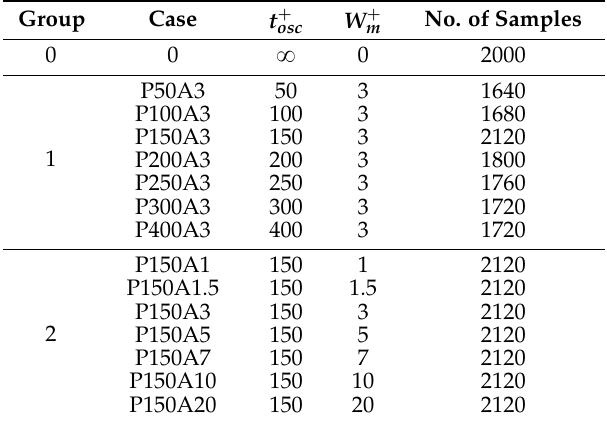
Table 1. Parameters of the wall